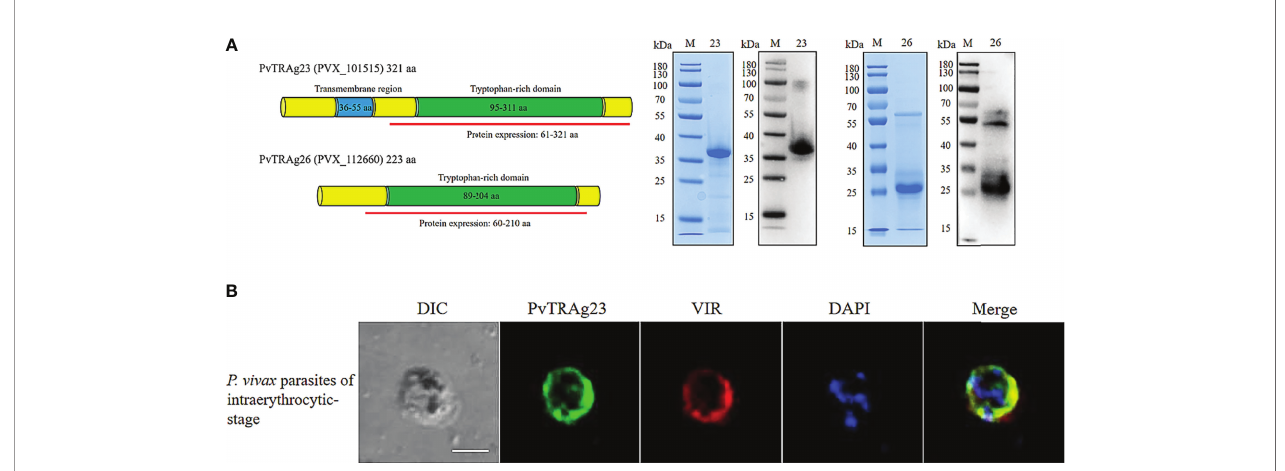
FIGURE 1 | The Expression and localization of rPvTRAg23 and rPvTRAg26. (A) Gene sequences and domains of pvtrag23 and pvtrag26 were obtained from PlasmoDB. Fragments containing tryptophan-rich domains were selected for expression and linked to pET30a vector with His-tag (left). rPvTRAg23 and rPvTRAg26 proteins were puri fi ed from E. coli cells by Ni-Sepharose column under non-denaturing conditions. Puri fi ed rPvTRAg23 and rPvTRAg26 were separated by SDS- PAGE and stained with Coomassie blue, and the expressions of His-tag on recombinant proteins were con fi rmed by western blot analysis with anti-His antibody (right). M, Molecular size marker. 23, rPvTRAg23. 26, rPvTRAg26. (B) P. vivax parasites were probed with rabbit anti-PvTRAg-23 antisera (1:50) and mouse anti-VIR antibody (1:100), followed by Alexa Fluor 488-conjugated donkey anti-rabbit IgG (1:500, green) and Alexa Fluor 568-conjugated goat anti-mouse IgG (1:500, red). Parasite nuclei were stained with DAPI (blue). The bar represents 5 m m. DIC, bright- fi eld